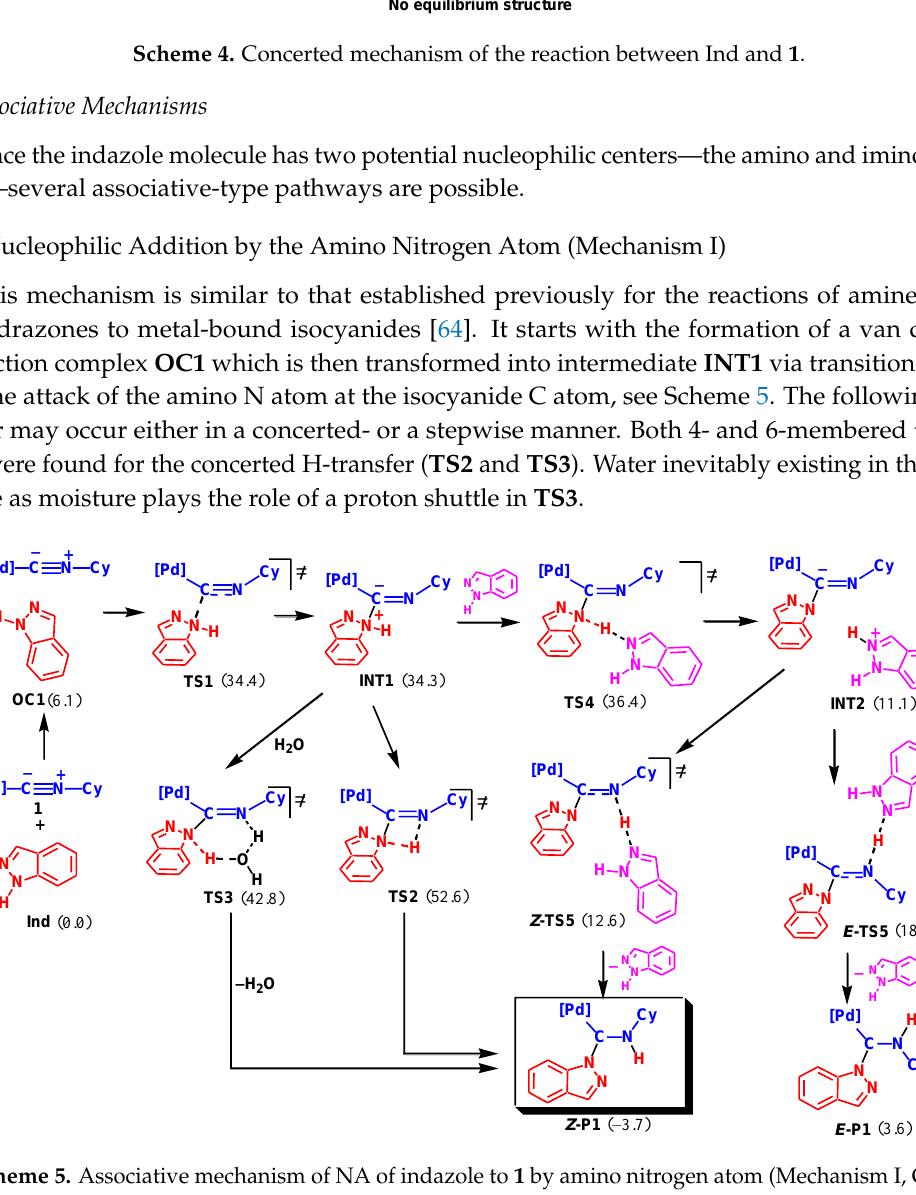
Scheme 5. Associative mechanism of NA of indazole to 1 by amino nitrogen atom (Mechanism